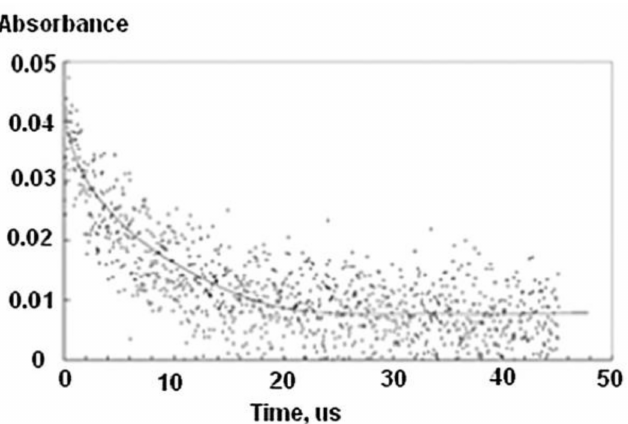
Figure 10. Decay profile kinetics at 390 nm of C-centered radicals in pulsed N 2 O-saturated aqueous solutions of 2.54 × 10 − 6 mol L − 1 PVP ( M w = (3.94 ± 0.12) × 10 5 g mol − 1 ) at 25 ◦ C, pulse width 3 µ s, dose per pulse 32 Gy. Adapted with permission from [22]; published by Elsevier,